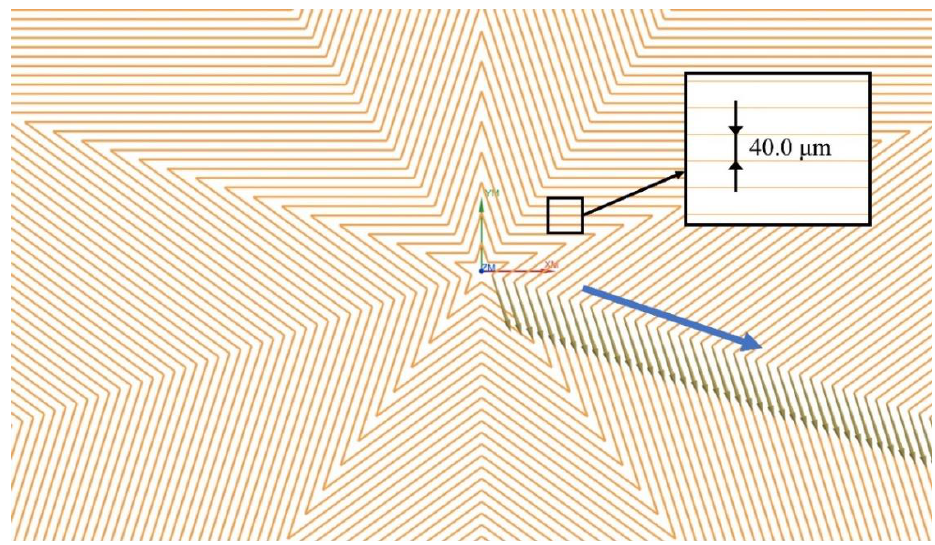
Figure 7. Derived paths of laser-surface interaction points based on the topology of parallel contours of pentagon.